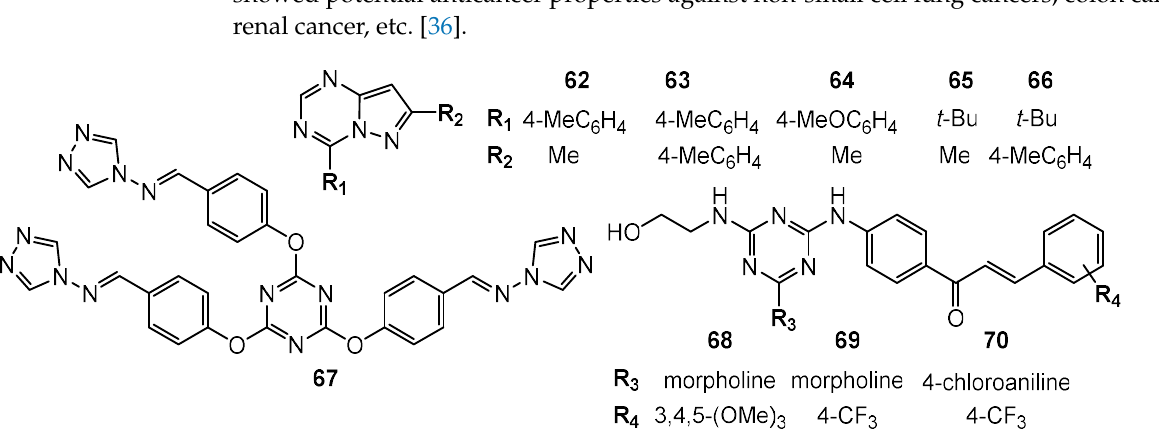
Figure 13. Structures of compounds 61–70 .